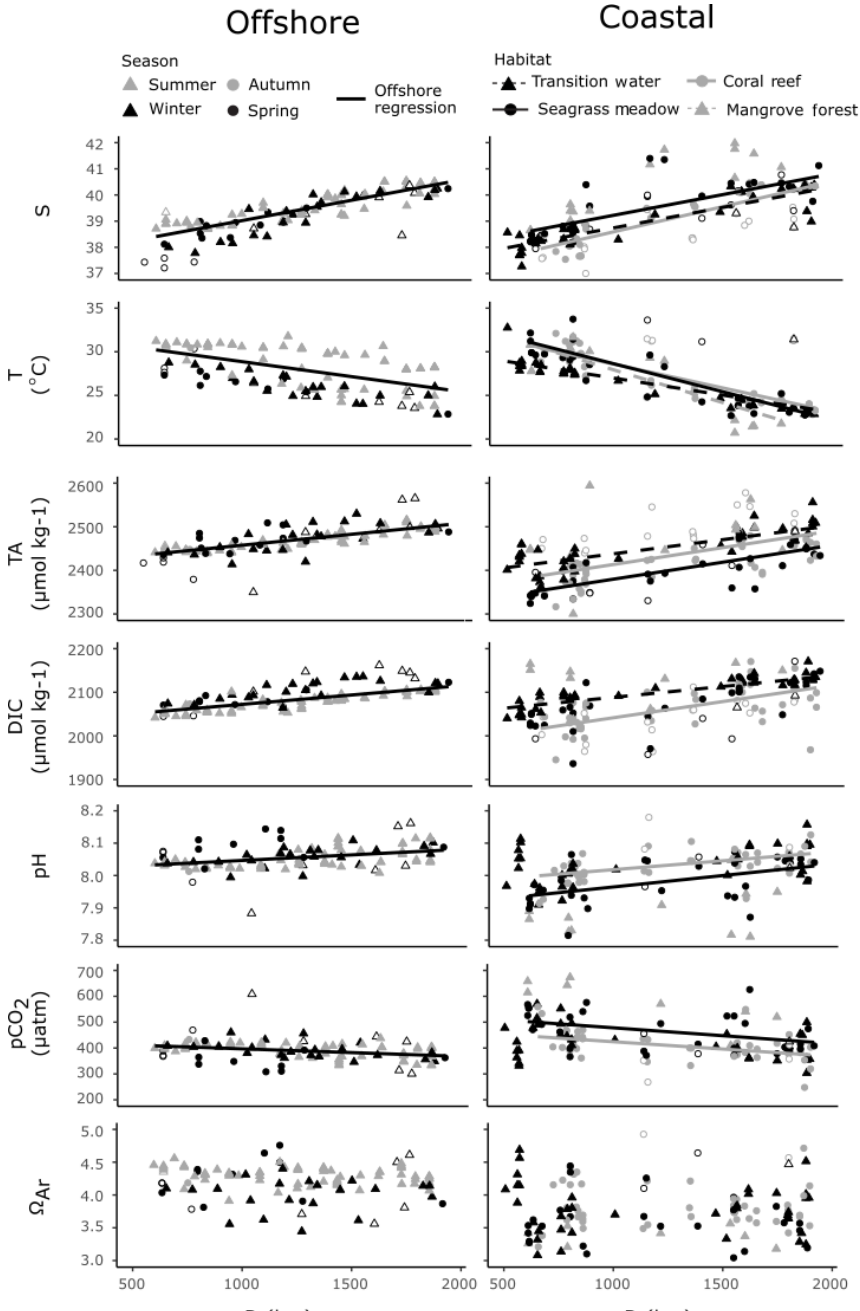
Figure 4. Offshore observations of S , T and carbonate parameters (left) and four coastal habitats (right) are presented against distance along the south–north central axis ( D ), on the same scales. Significant linear regressions for all combinations of variables are drawn as lines, with associated statistics reported in Table S3. Offshore outliers were not included in determining offshore regressions against D . Coastal observations from time series stations and an outlying mangrove observation were not included in regressions against D . Note that not all coastal observations are displayed, and an expanded scale is shown in Fig. 6. Hollow symbols indicate offshore outliers (right panels) and coastal summer observations (left